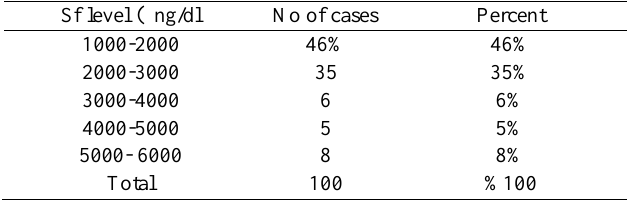
Distribution of patients according to serum ferritin before and after starting desferrioxamine therapy is show in tables (2&3) Table 2 : Serum ferritin levels before desferrioxamine chelation therapy